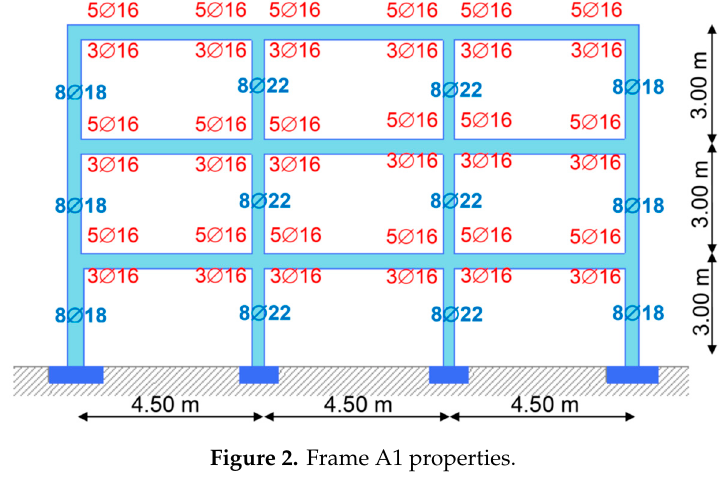
Figure 2. Frame A1 properties.